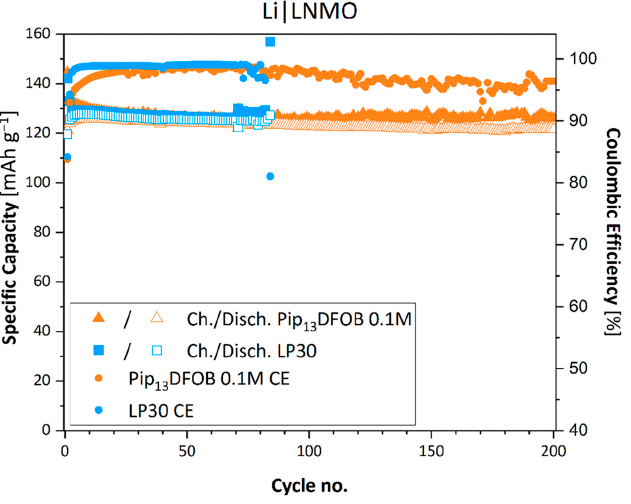
Figure 8. Galvanostatic cycling performances of Li|LNMO at 1C.